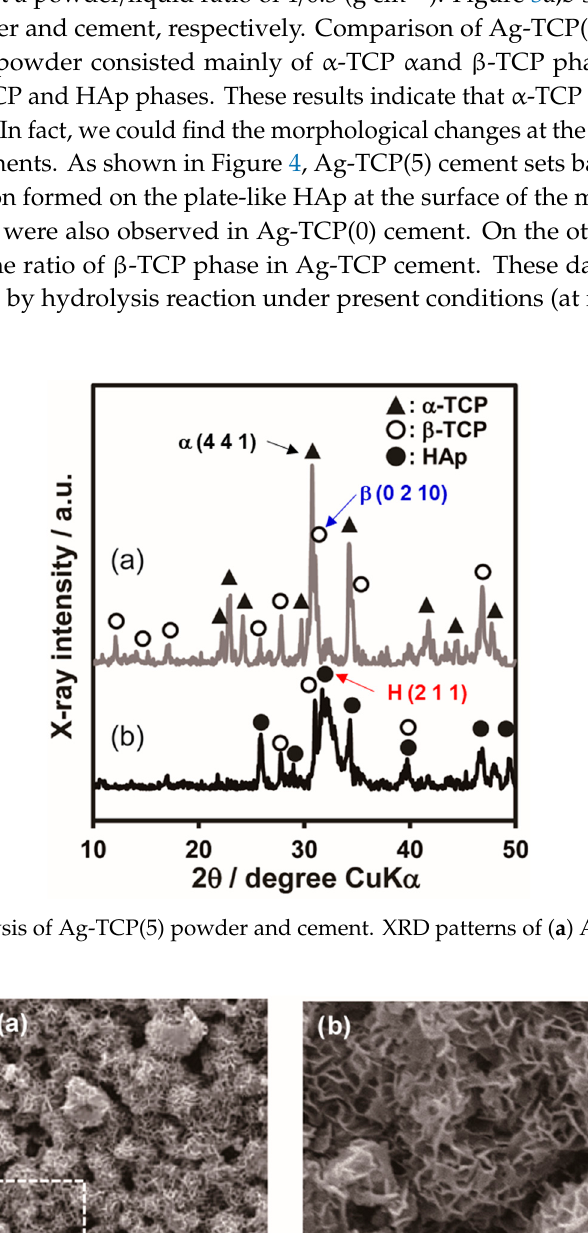
Figure 5. Evaluation of anti-washout property of Ag-TCP cement. Ag-TCP(5) and Ag-HAp(5) cements were immersed into water for 24 h after setting. Ag-TCP(5) cement had anti-washout property ( a ), though Ag-HAp cement collapsed ( b ). Next, to assess the in vitro release kinetics of Ag + ions from cements, Ag-TCP(0) and Ag-TCP(5) cements were immersed in Luria-Bertani (LB) media for 3, 5, 7, 14, and 21 days. The cumulative Ag + ions, Ca 2+ ions, and PO 43 − ions were measured by ICP-AES (Figure 6). ICP-AES analysis showed that almost equal amounts of Ag + ions (4.86 × 10 − 3 μ g/mg for day 3, 5.37 × 10 − 3 μ g/mg for day 5, 5.50 × 10 − 3 μ g/mg for day 7, and 4.55 × 10 − 3 μ g/mg for day 14) were released in the first 14 days, after which the release levels decreased slightly (Figure 6a). Furthermore, the cumulatively released Ca 2+ and PO 43 − ions in the LB medium at each time point were investigated (Figure 6b,c). In the first three days, large amounts of Ca 2+ and PO 43 − ions released from each sample. The concentration of Ca 2+ and PO 43 − released from Ag-TCP(5) cement was higher than that of Ag-TCP(0), and this contributed to the low crystallinity of Ag-TCP(5). The end products mainly consisted of β -TCP and HAp. Although sintered HAp is more stable, CPCs with low crystallinity fabricated in this study could be dissolved and released Ca 2+ , PO 43 − , and Ag + ions for a long term. In vivo situation, they can be degraded by different two ways as follows: (i) active resorption controlled by macrophages and osteoclasts; (ii) passive resorption thorough chemical dissolution or hydrolysis in body fluid.